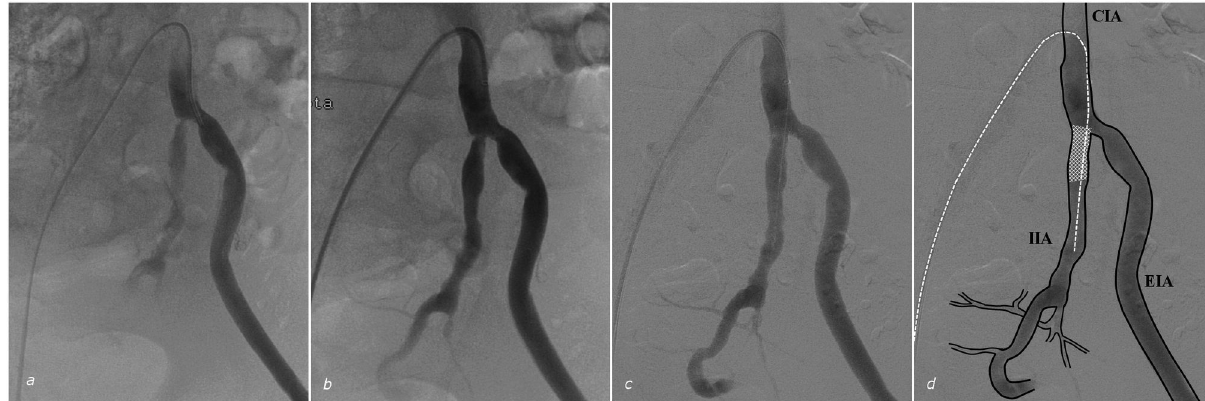
Figure 2. Treatment of a patient. (a) Digital subtraction angiography of the left common iliac artery showing a proximal stenosis of the internal iliac artery (IIA), with sub-optimal filling of subsequent branches. (b) Result after treatment with 5 and 6 mm percutaneous transluminal angioplasty, showing residual origin stenosis of the IIA of more than 30%. (c) Subsequent stent placement (Palmaz 6 mm diameter) reduced the stenosis grade to less than 30%, and provided adequate distal blood flow. (d) Overlay of Figure c showing branches of mentioned vessels, guide wire position (white dotted line) and placed stent (white mesh). CIA = Common Iliac Artery. EIA = External Iliac Artery. IIA = Internal Iliac